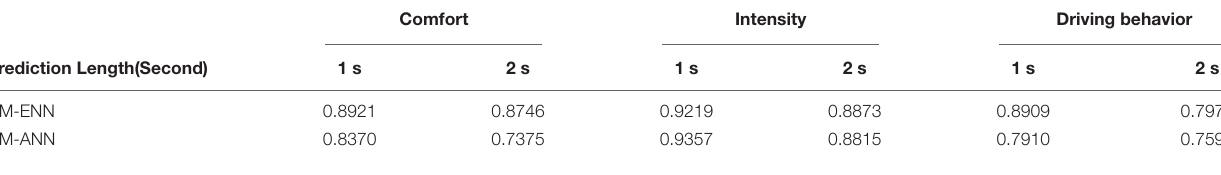
TABLE 7 | The accuracy of dangerous driving behavior prediction by Elman neural network (CM-ENN) and CM-ANN. Comfort Intensity Driving